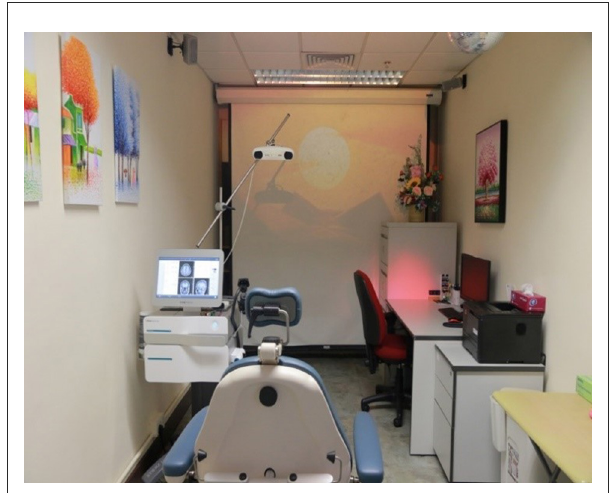
FIGURE4 Transcranial pulse stimulation system and TPS treatment venue in